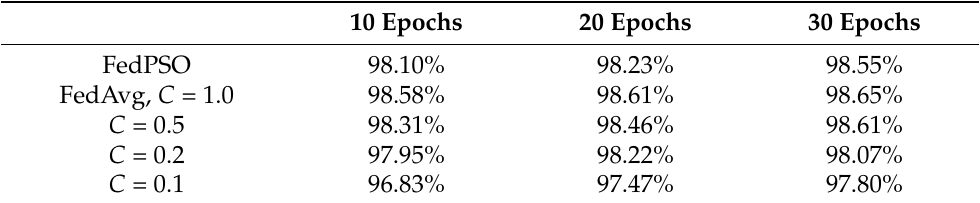
Figure 6. Comparison of learning accuracy using MNIST. Table 4. Test